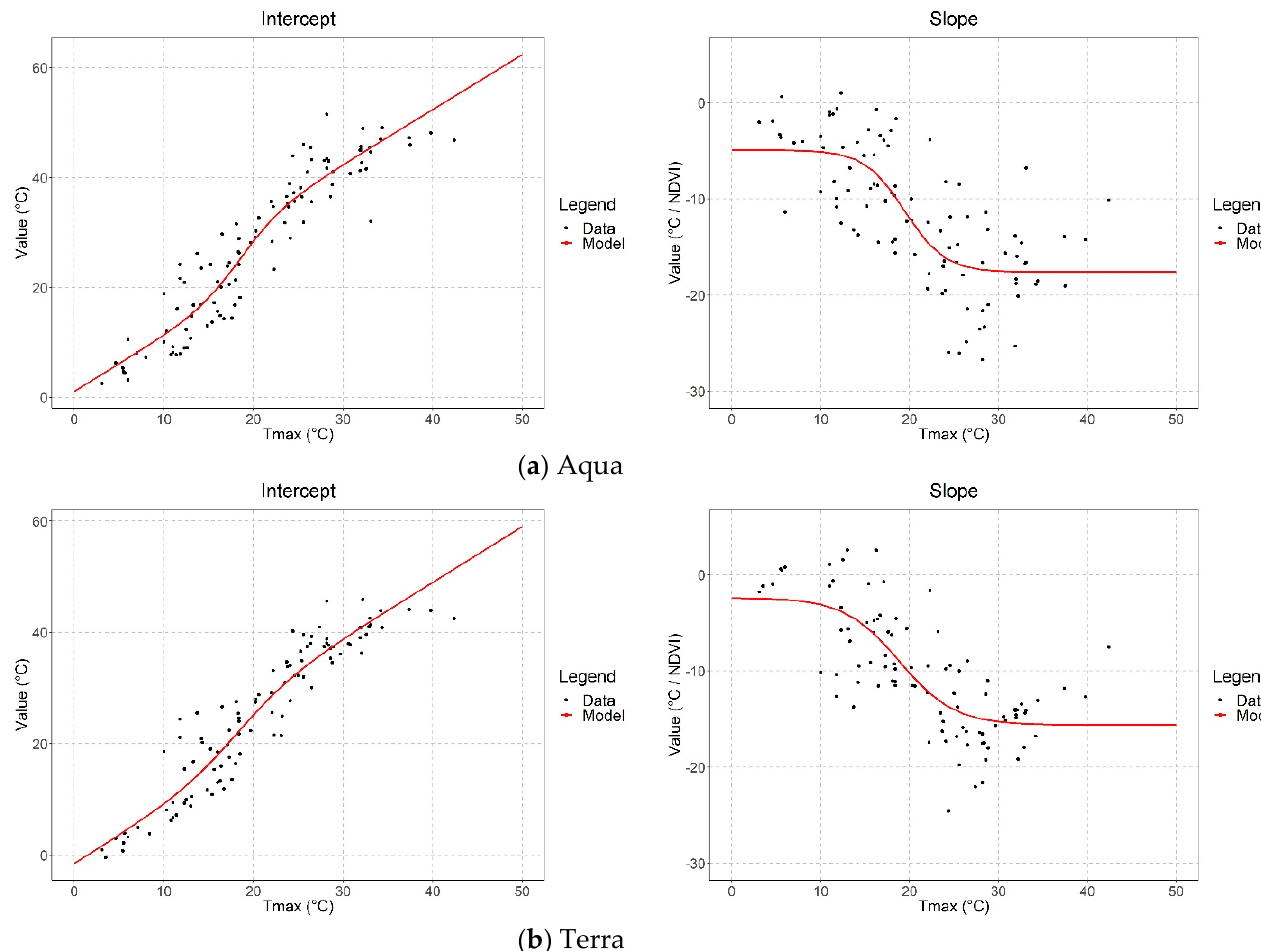
Figure 5. DisTrad intercept and slope for ( a ) Aqua and ( b ) Terra as a function of daily maximum air temperature. Table 1. Model parameters—Aqua.